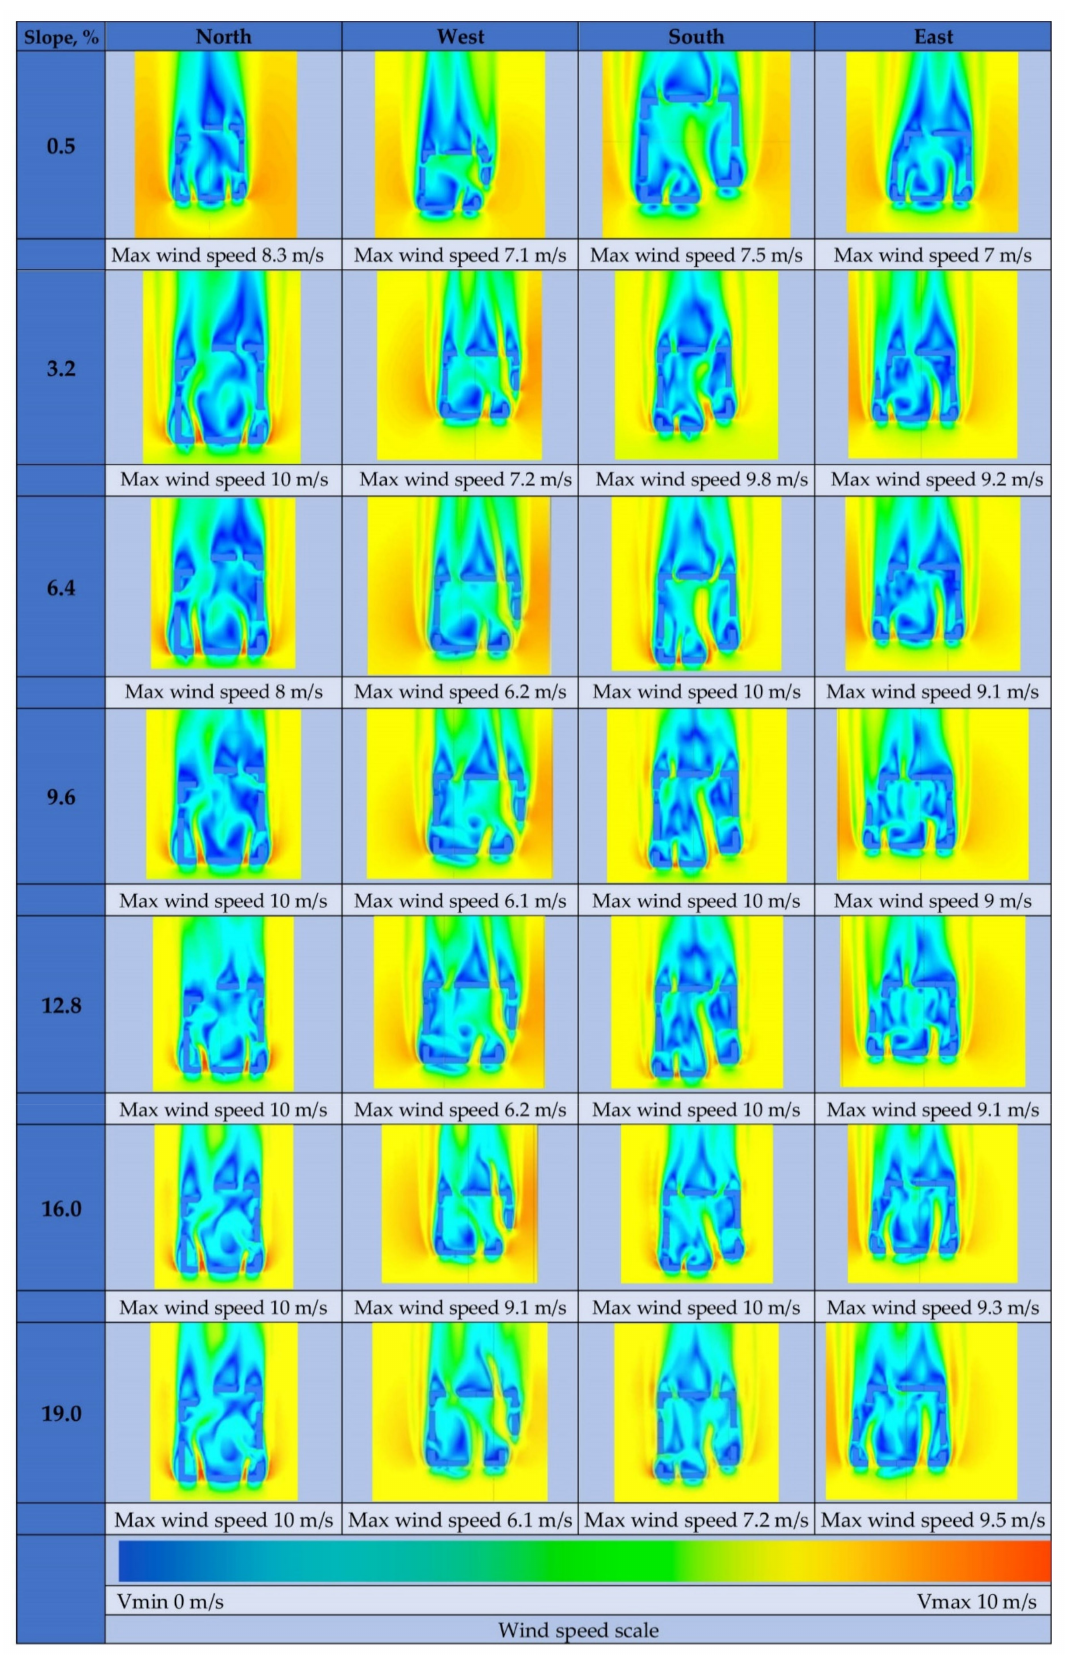
Figure 5. Velocity fields under average temperature of − 18 ◦ C and wind velocity of 4 m/s for various combinations of slopes gradient and